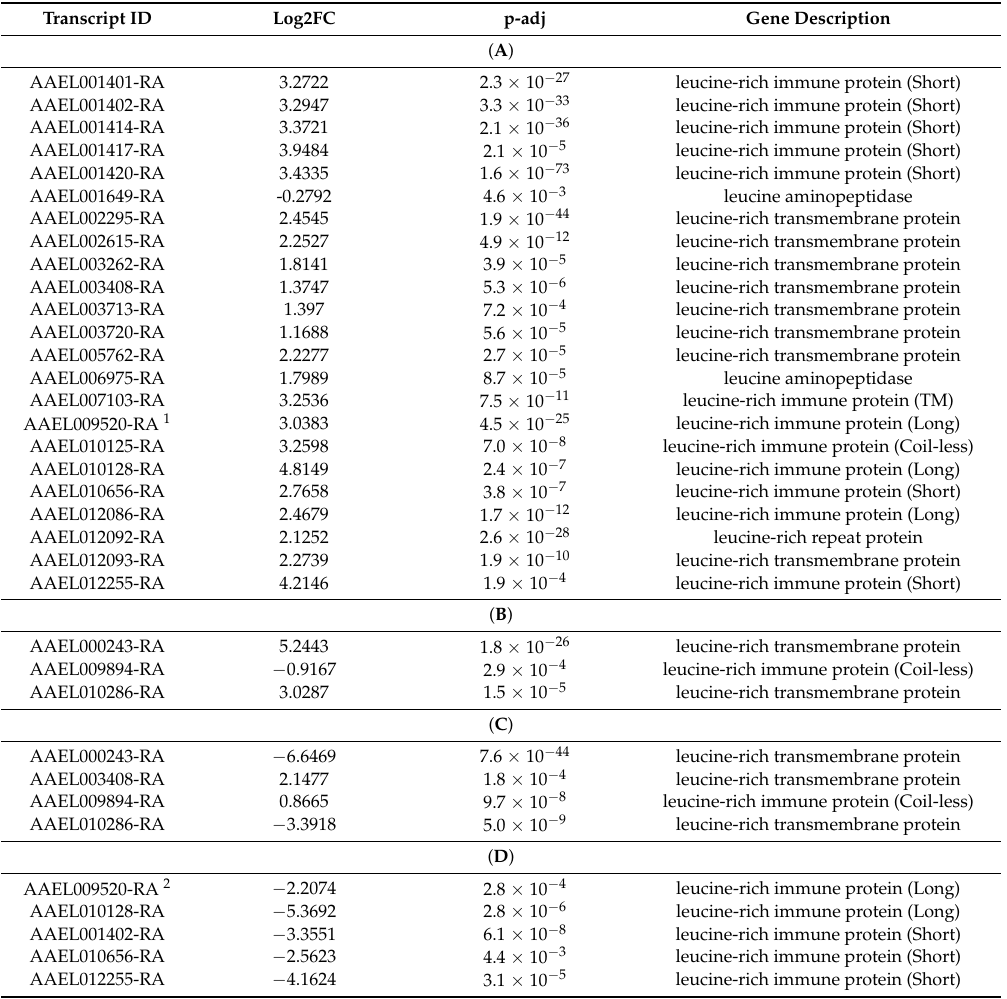
Table 1. ( A ) Female Aedes aegypti transcriptomic RNA-seq data show leucine-rich repeat proteins related genes significantly upregulated in the Zika infection in the Key West strain compared with the Orlando strain Aedes aegypti 7-days post infection (Log2FC, Log2 fold change); ( B ) female Aedes aegypti transcriptomic RNA-seq data show leucine-rich repeat proteins related genes significantly upregulated/downregulated in the control (uninfected blood-feeding only) in the Key West strain compared with the Orlando strain Aedes aegypti 7-days post injection; ( C ) female Aedes aegypti transcriptomic RNA-seq data show leucine-rich repeat proteins related genes significantly dysregulated in the Key West strain Aedes aegypti 7-days post infection with ZIKV compared with control (uninfected blood-feeding only) in the Key West strain; ( D ) female Aedes aegypti transcriptomic RNA-seq data show leucine-rich repeat proteins related genes significantly dysregulated in the Orlando strain Aedes aegypti 7-days post infection with ZIKV compared with control (uninfected blood-feeding only) in the Orlando